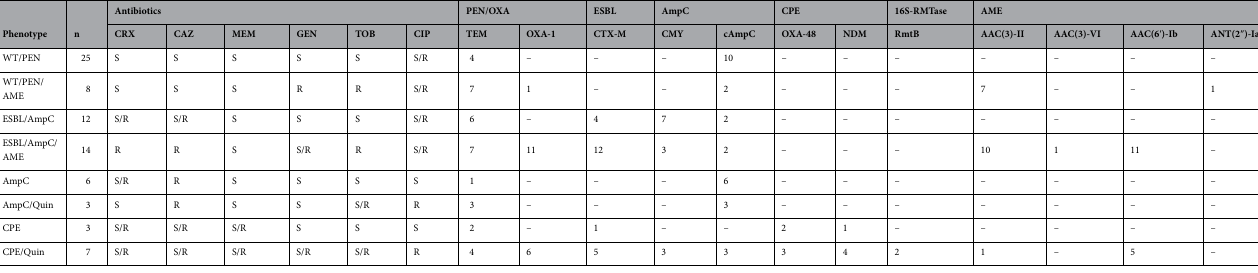
Table 3. Seventy-eight E. coli isolates classified according to their beta-lactamase phenotype including the detected resistance mechanisms against beta-lactams and aminoglycosides by LC–MS/MS. Isolates were classified based on their susceptibility (S) or resistance (R) to ceftriaxone (CRX), ceftazidime (CAZ), meropenem (MEM), gentamicin (GEN), tobramycin (TOB) and ciprofloxacin (CIP) into wild type (WT) isolates and small spectrum penicillinase (PEN) and/or oxacillinase-producing (OXA) isolates, extended-spectrum beta-lactamase producers (ESBL) in combination with isolates producing AmpC beta- lactamases (AmpC), isolates that only produced E. coli chromosomal AmpC, or carbapenemase producing Enterobacterales (CPE). Isolates were further divided based on aminoglycoside resistance, mostly caused by aminoglycoside modifying enzymes (AME), and/or quinolone resistance (Quin). Small spectrum beta- lactamases/oxacillinases included TEM and OXA-1. ESBL and AmpC were represented by CTX-M, CMY and E. coli chromosomal AmpC. Carbapenemase producing Enterobacterales (CPE) included OXA-48 and New Delhi Metallo beta-lactamase (NDM) producing isolates. Mechanisms of aminoglycoside resistance included the 16S rRNA methyltransferase (rmtB), the acetyltransferases AAC(3)-II, AAC(3)-VI and AAC(6 ′ )-Ib, and the nucleotidyltransferase ANT(2 ″ )-I.